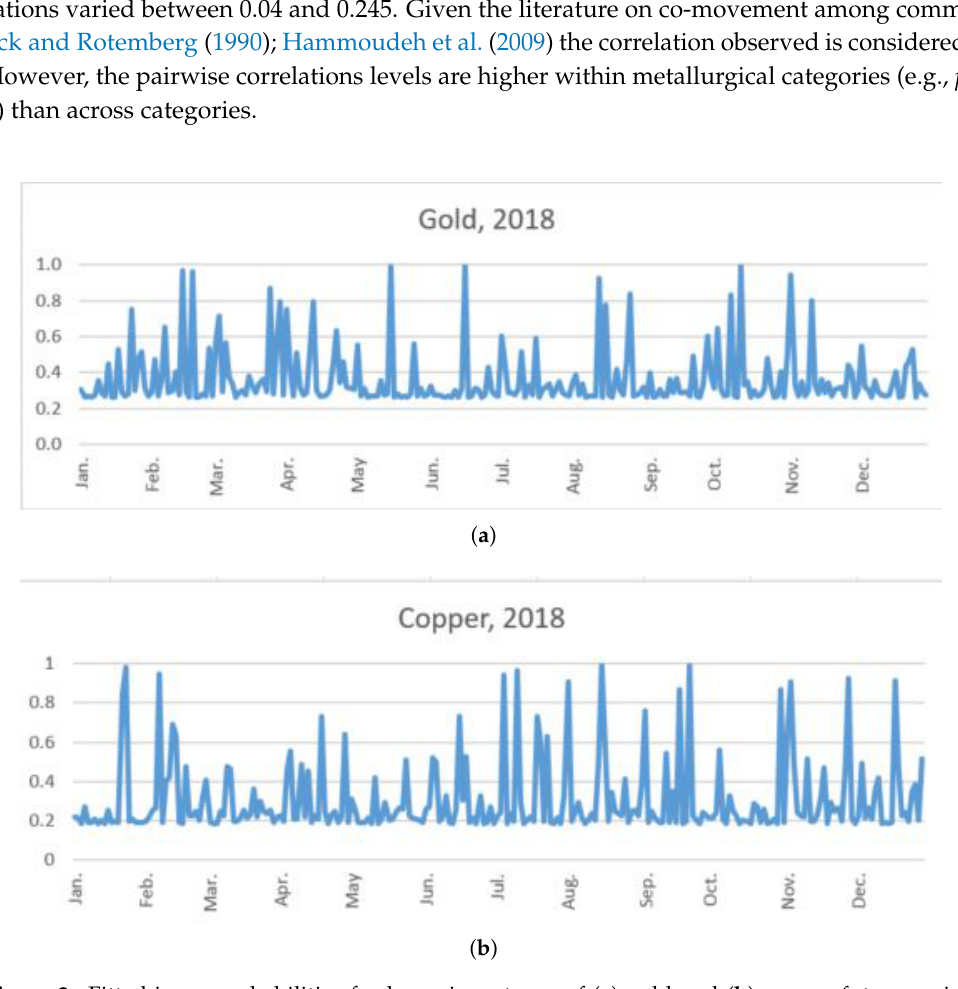
Figure 2. Fitted jump probabilities for log price returns of ( a ) gold and ( b ) copper futures prices, for